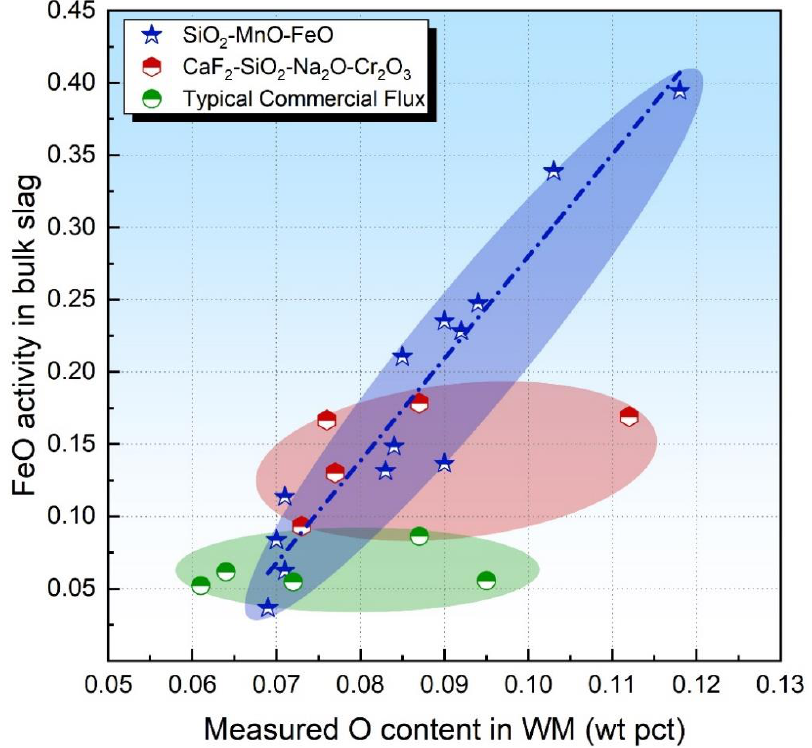
Figure 2. FeO activity in bulk slag as a function of measured O content in WM.